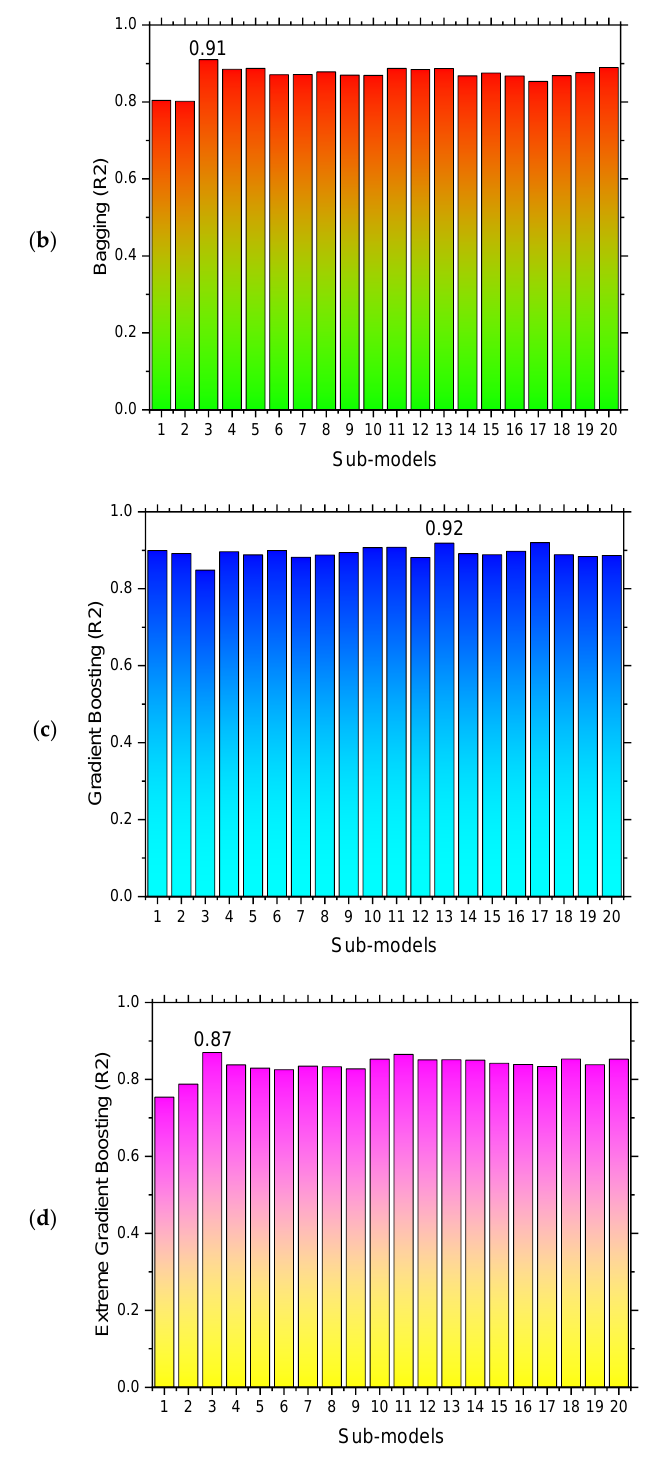
Figure 13. ( a ) AdaBoost; ( b ) bagging; ( c ) gradient boosting; and ( d ) extreme gradient boosting sub models’ outcomes.